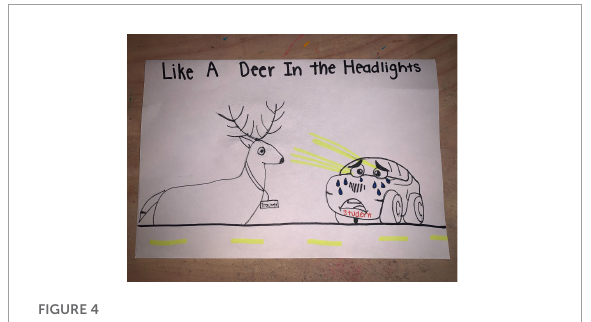
FIGURE5 Together, Winter 2021.